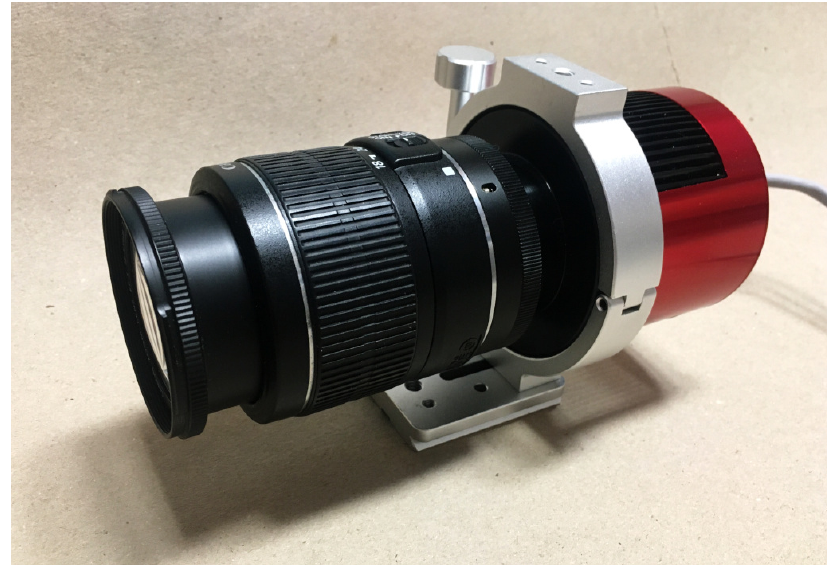
Figure 4. Camera with lens used in an experiment.